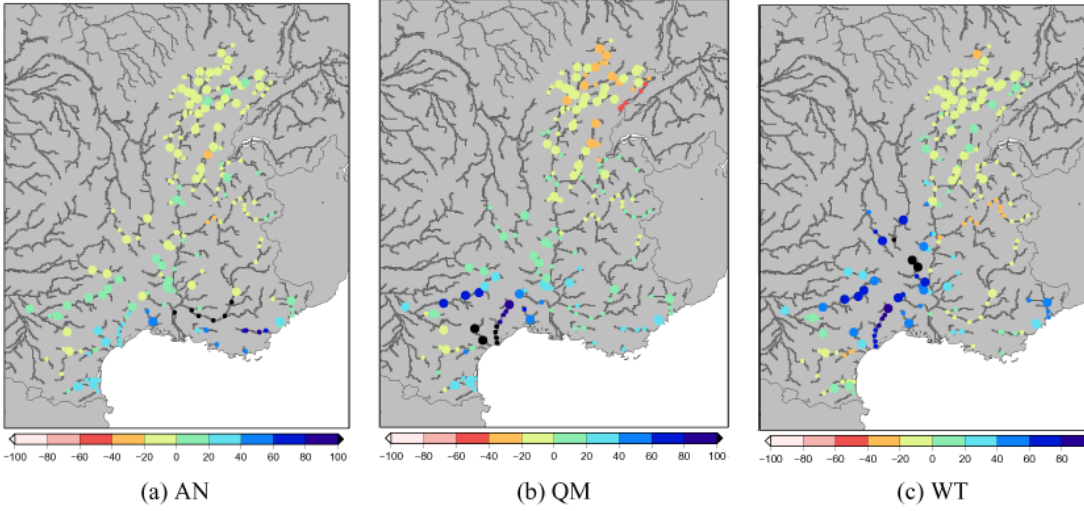
Fig. 15. Anomalies (2035–2064 vs. 1970–2099) of QJXA10 (in %).